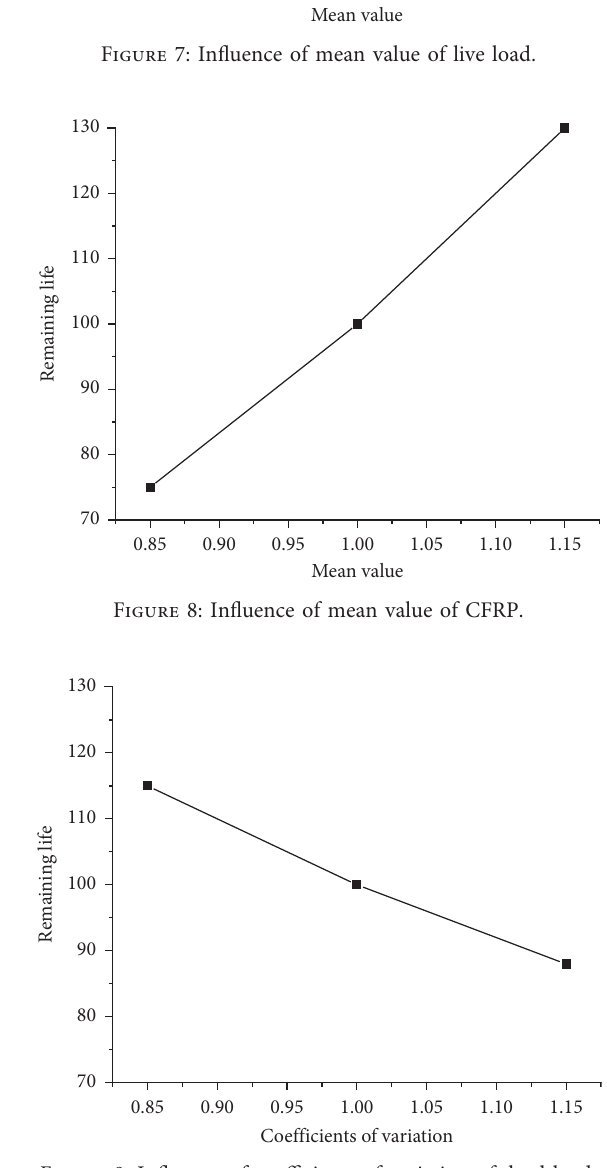
Figure 9: Influence of coefficients of variation of dead load.